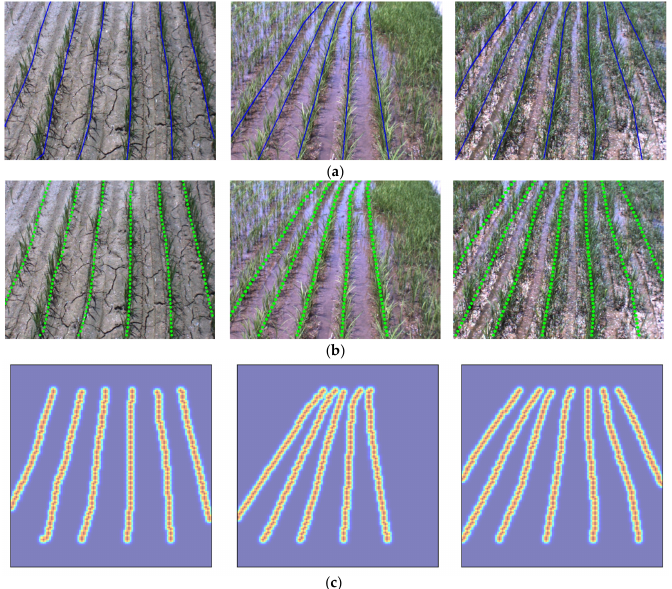
Figure 3. Labelling styles: ( a ) Use broken lines to label the rice seedling rows; ( b ) Image of key points after labelling; ( c ) Generated Heatmaps.